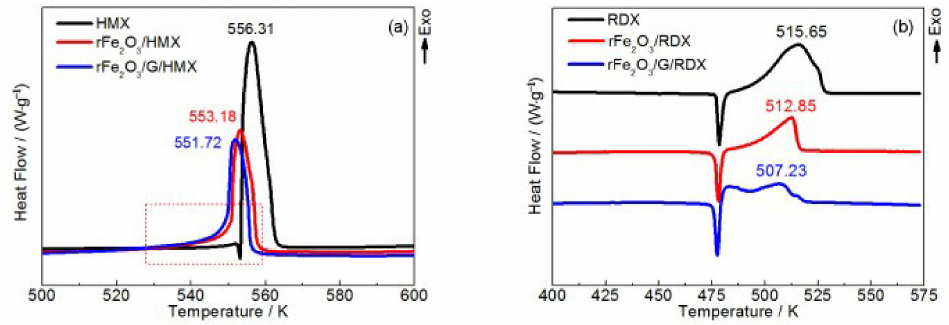
Figure 17. DSC curves of ( a ) rFe 2 O 3 /G and ( b ) rFe 2 O 3 mixed with HMX and RDX. ( a , b ) Reproduced with the permission of ref. [98]. Copyright 2020, Acta Physico-Chimica